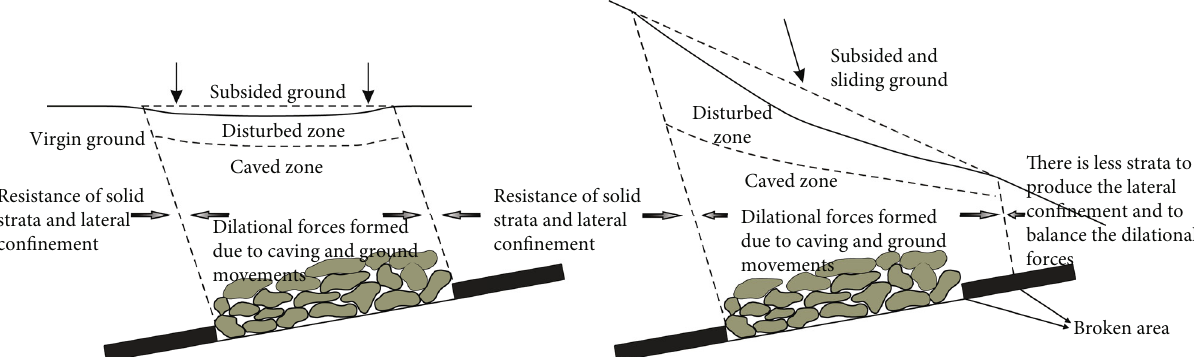
Figure 14: The gob overburden rock stress state of fl at/sloping terrain in mountainous areas ((a) fl at terrain and (b) sloping terrain, adapted from